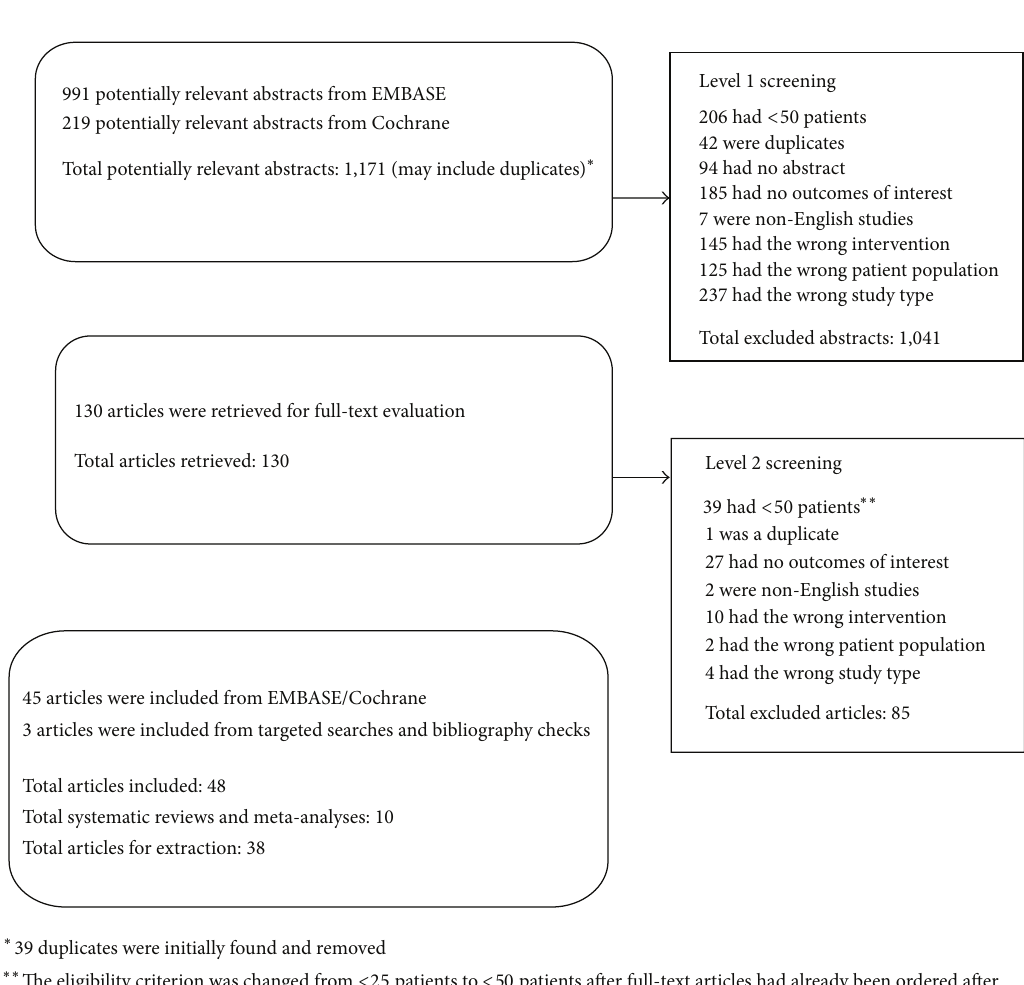
Figure 1: Identification and selection of full-text articles for